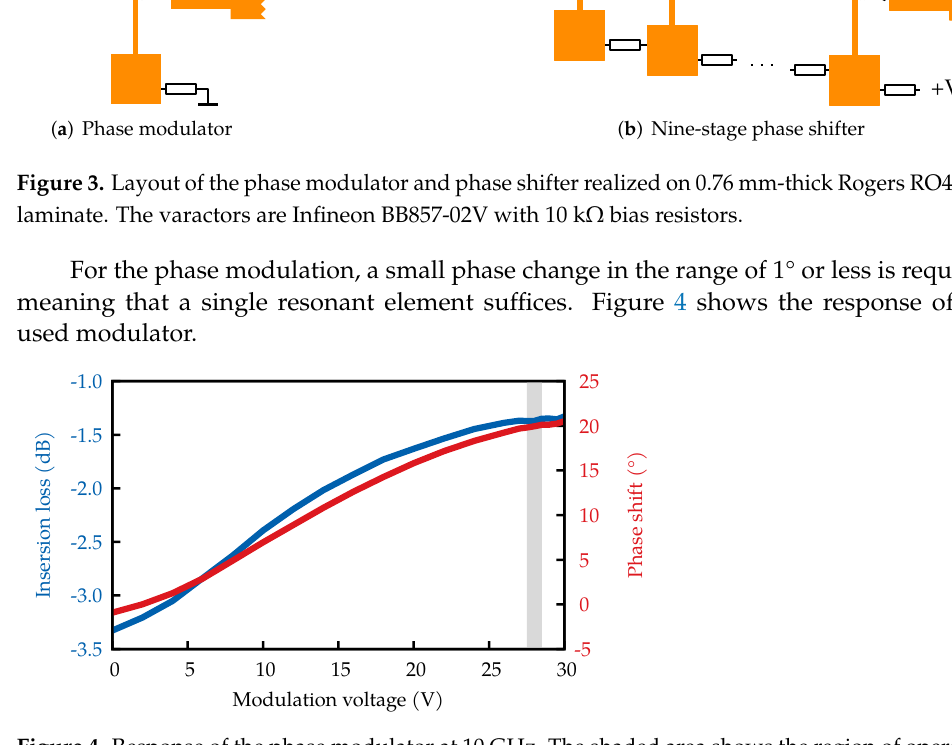
Figure 4. Response of the phase modulator at 10 GHz. The shaded area shows the region of operation in the presented